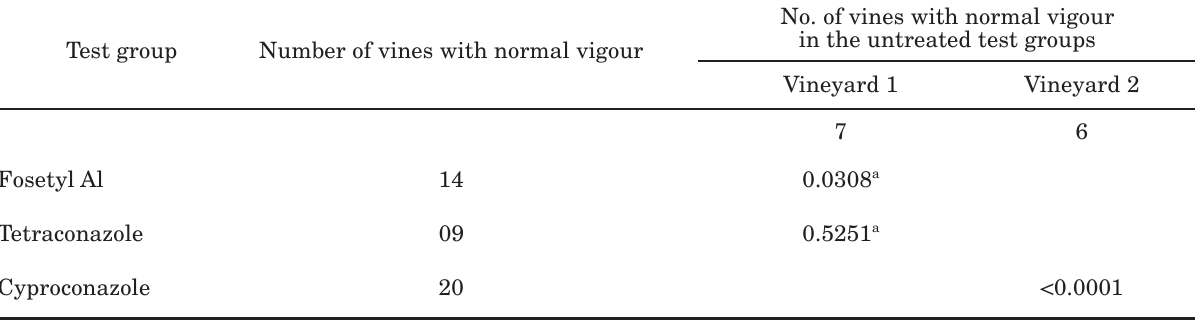
Table 4. Statistical analysis using “set of two (cid:1) r”. The treated test groups in the trunk-injected vineyards were compared with the corresponding untreated test group (trunk-renewal only) according to the frequency of vines in the classes “normal vigour”, as assessed in 2002.